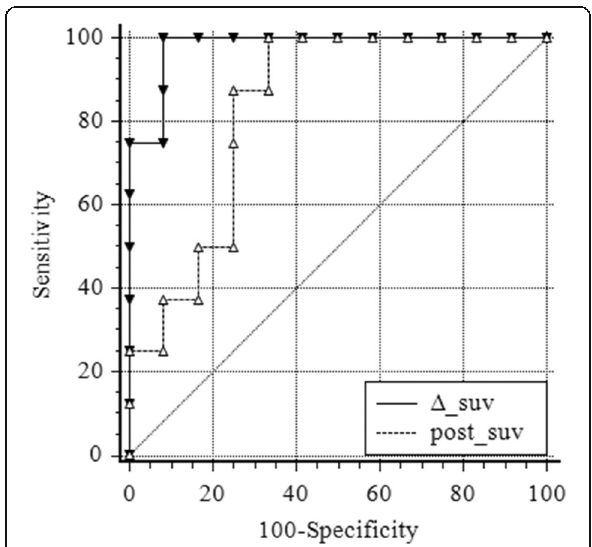
Fig. 3 Receiver operating characteristic curve analyses. The specificity and sensitivity of using post-treatment SUV and % change in SUV were compared. The AUC was 0.979 (95% CI, 0.930 – 1.000) and 0.833 (95% CI, 0.651 – 1.000) for % change in SUV and post- treatment SUV respectively. However, no significant difference in AUCs was identified between %change in SUV and post-treatment SUV ( P = 0.1284). AUC, area under the curve; CI, confidence